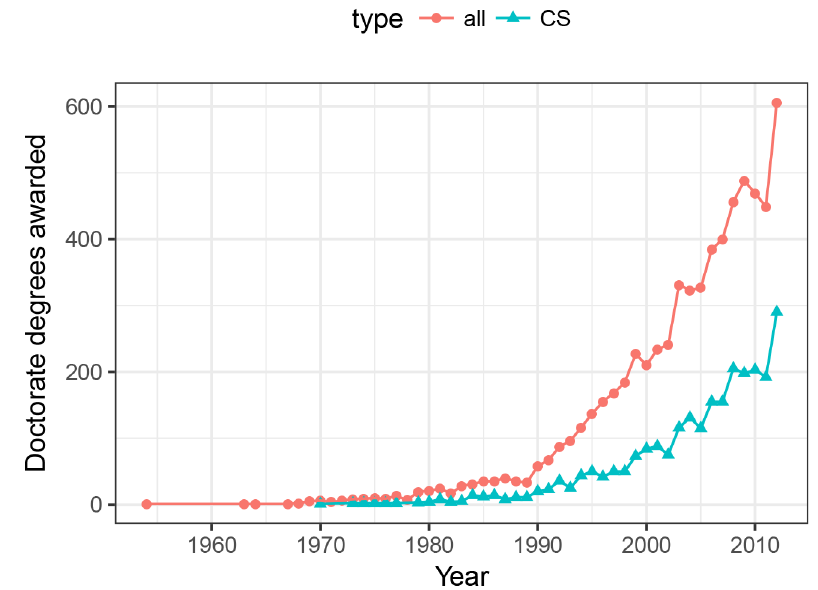
Figure 2 - Growth of number of doctorate degrees since the end of decade of 1980. Dots indicate number of doctorate degrees granted each year among those who declared to work in Computer Science. Curve labeled with “CS” indicates number of Computer Science degrees and “all” is unrestricted among those who work in the Computer Science field.